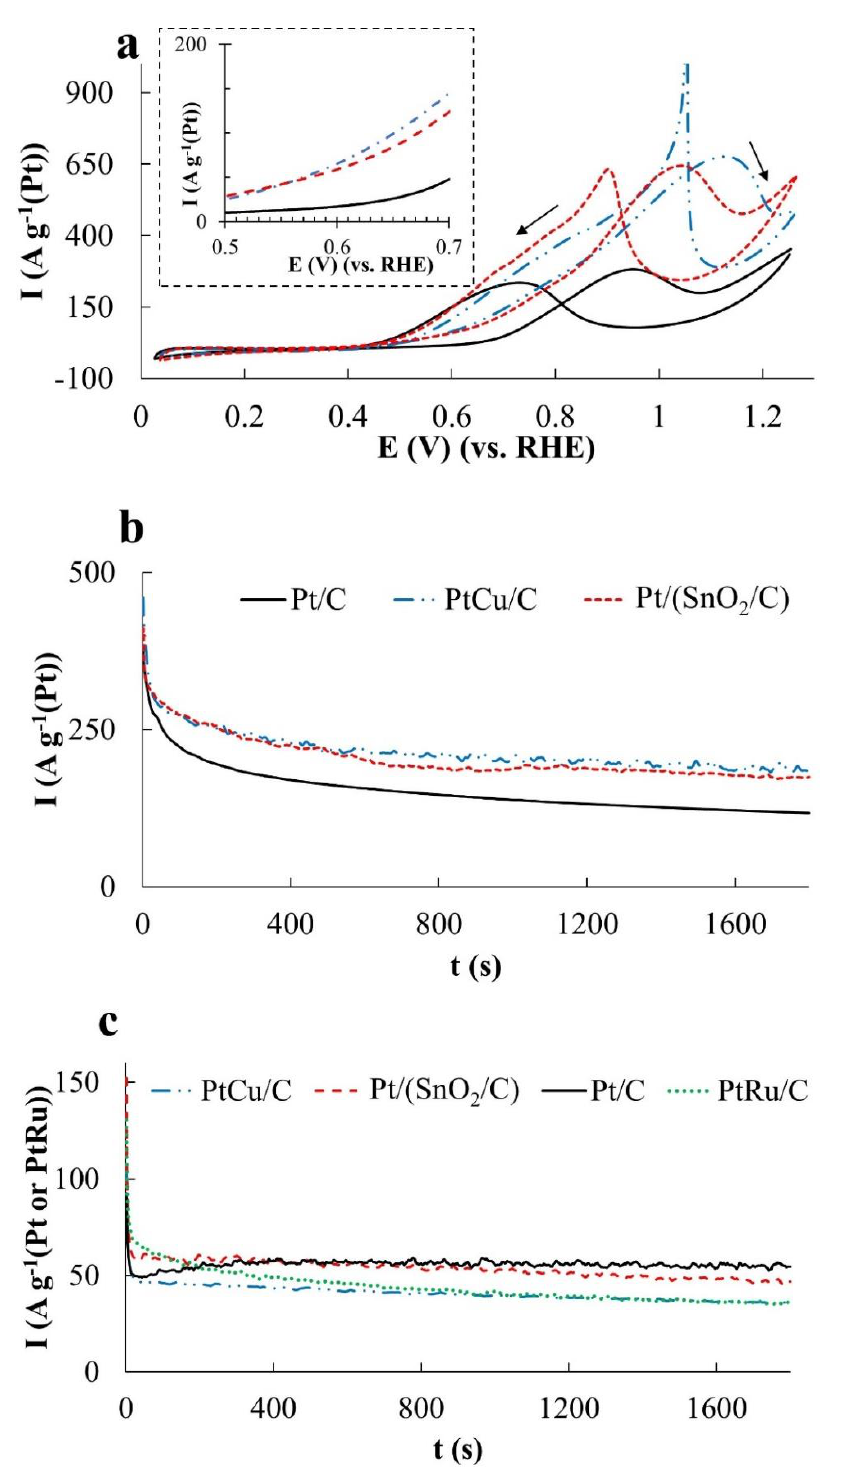
Figure 6. Parameter values, which characterize catalyst activity in ( a ) methanol (MOR), ( b ) ethanol (EOR), and ( c ) formic acid (FAOR).